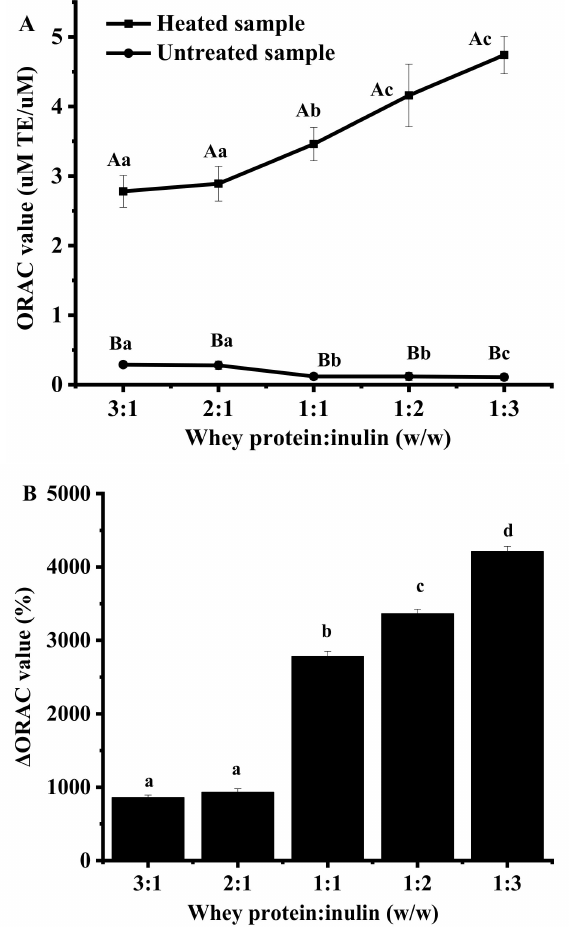
Figure 6. Oxygen radical absorbance capacity (ORAC) values ( µ M TE / µ M) of heated and untreated whey protein and inulin mixtures ( A ) and changes in ORAC value of whey protein and inulin mixture after heating ( B ). Di ff erent lowercase letters denote significant di ff erence in ORAC values between samples with di ff erent whey protein and inulin ratios for untreated or dry-heated samples; Di ff erent uppercase letters denote significant di ff erence in ORAC values between untreated and dry-heated samples at same whey protein and inulin